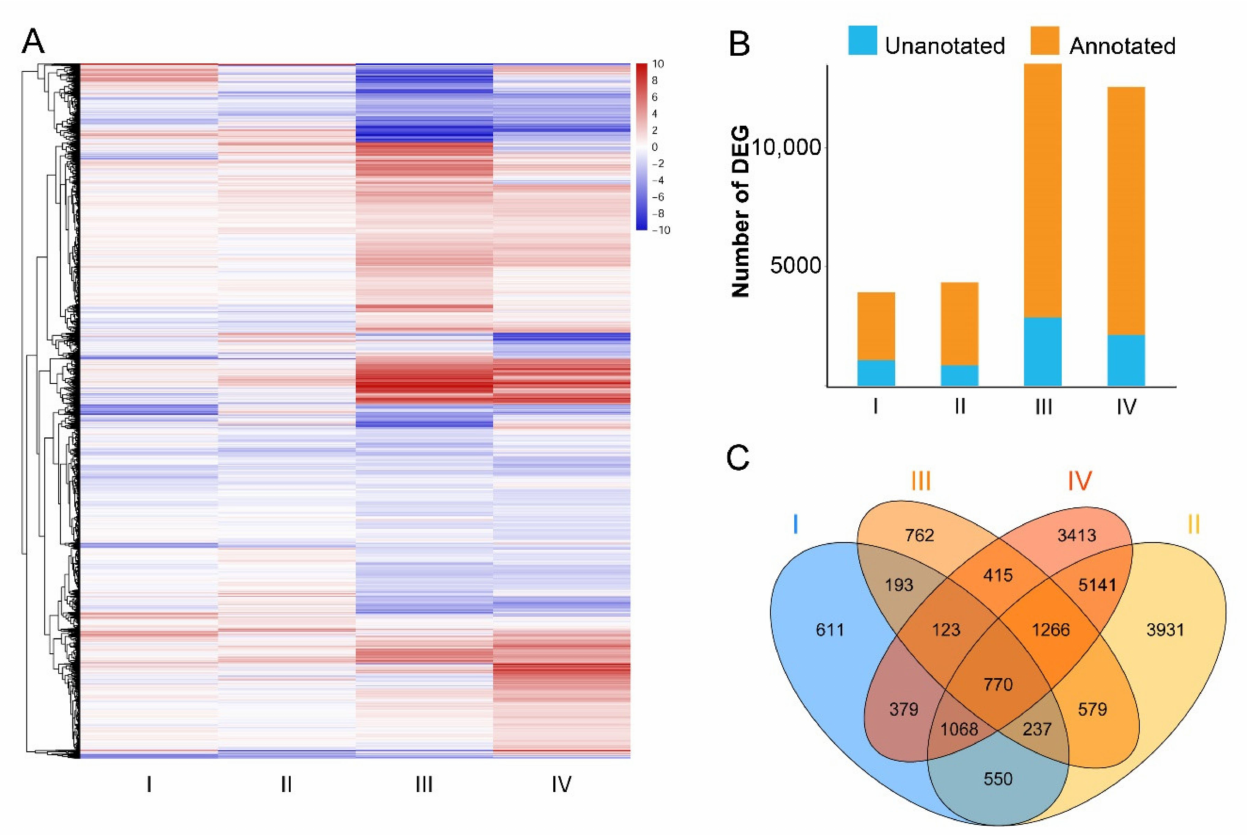
Figure 3. Screening of DEGs in development-specific variation; ( A ) heatmap of DEGs in comparison between different stages; ( B ) number of DEGs in comparison between different stages; ( C ) Venn diagram of unique and common DEGs in comparison between different stages. I, DAN3130 DAP 24 versus DAP 35; II, JI63 DAP 24 versus DAP 35; III, DAN3130 DAP 35 versus mature kernel; IV, JI63 DAP 35 versus mature